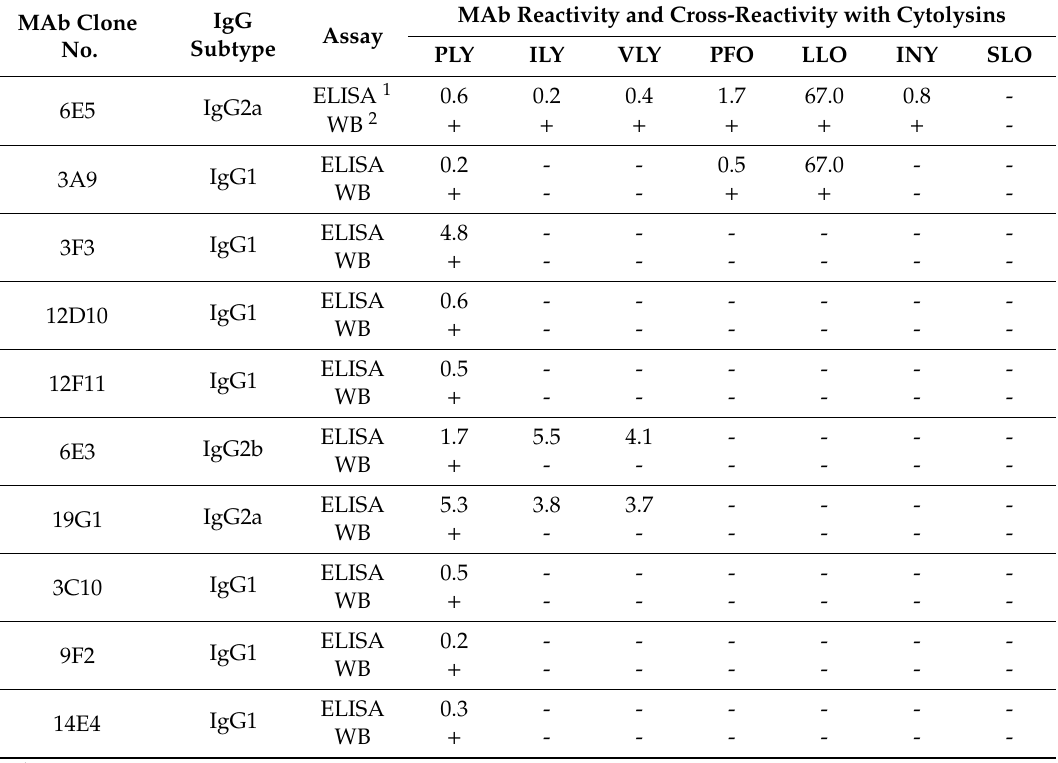
Table 5. Characterisation of the monoclonal antibodies (MAbs) raised against recombinant PLY. MAb Reactivity and Cross-Reactivity with IgG MAb Clone Assay No.